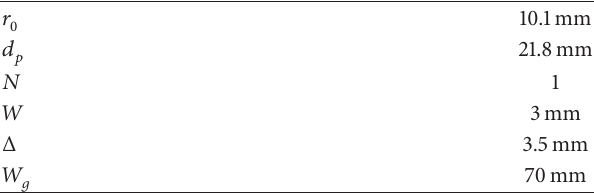
Table 1: The geometrical parameters of the final